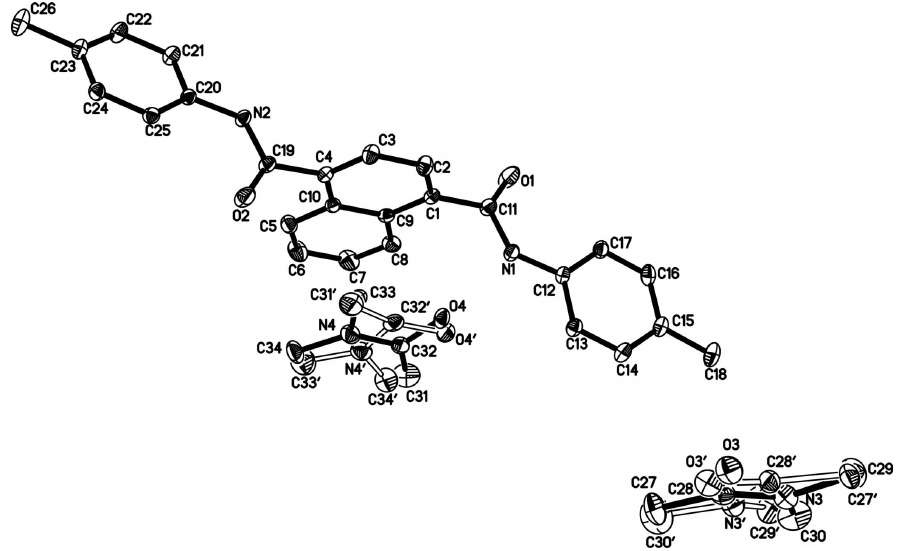
Figure 1 The asymmetric unit of the title compound. Displacement ellipsoids are drawn at the 30% probability level. All disordered components are shown. H atoms have been omitted for